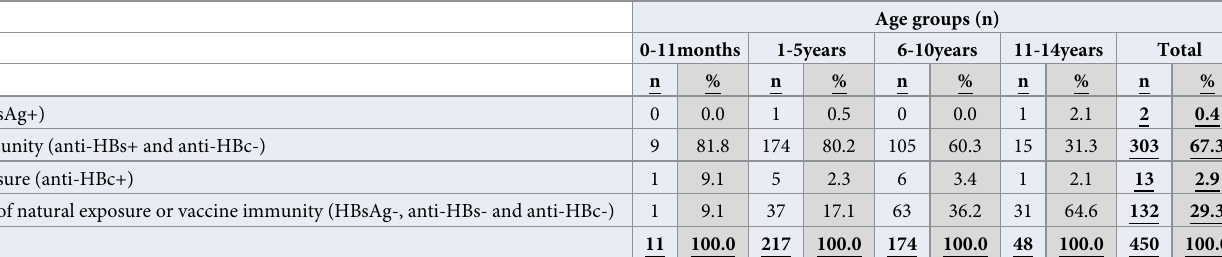
Table 1. Hepatitis B serology in residual sera from patients with febrile rash illness, by age